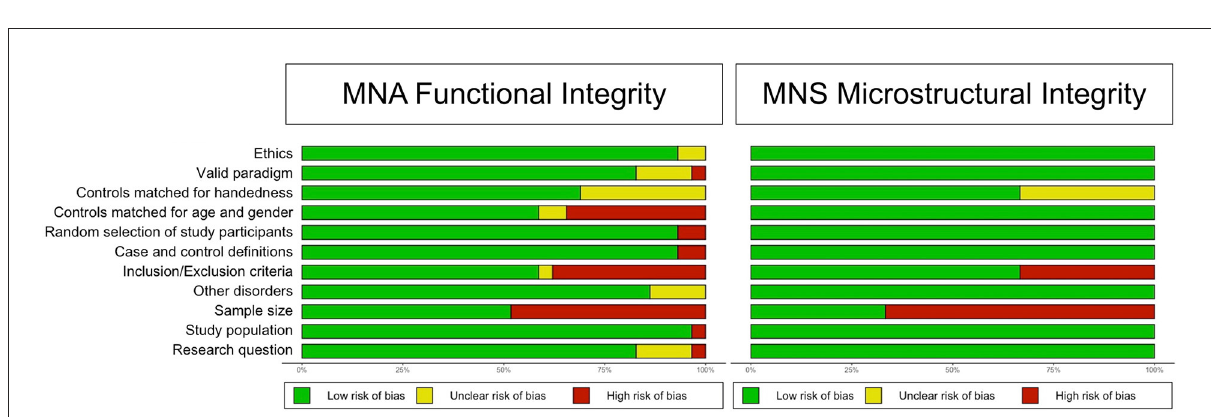
FIGURE2 Methodological and reporting quality graph: Review authors’ judgments about each methodological and reporting quality item presented as percentages across all included studies.